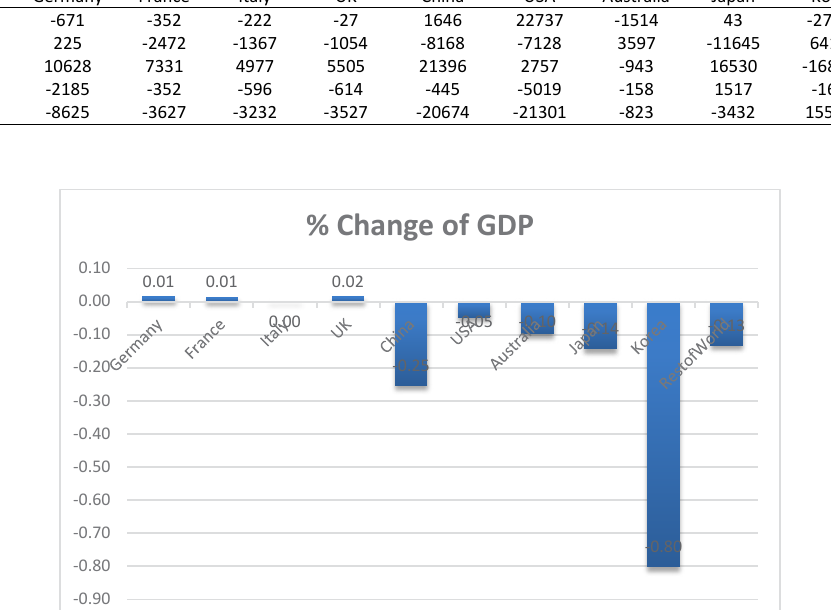
Table 3: Change in trade balances by sector (US millions of dollars) Sectors